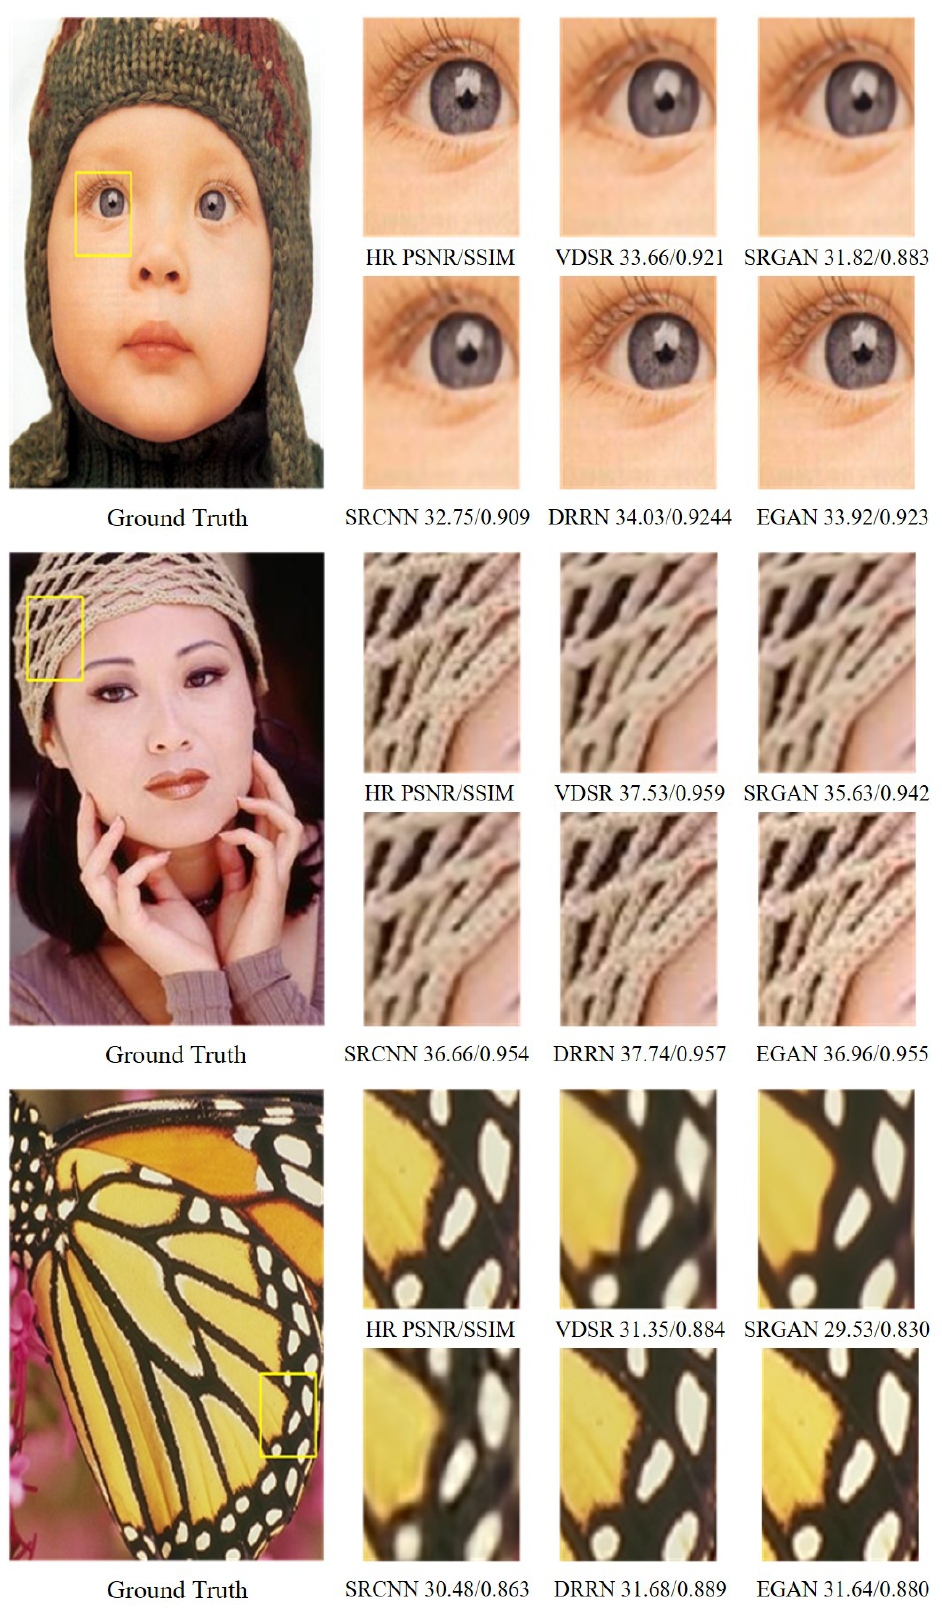
Figure 7. Visual comparisons for ×2, ×3, and ×4 SR on Set5, image “woman” with scale factor ×2, image “baby” with scale factor ×3, and image “butterfly” with scale factor ×4 are shown, respectively, in the 3